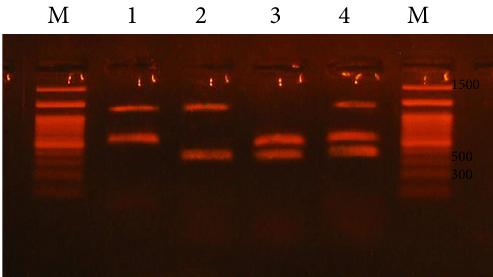
Fig. 5. Multiplex PCR for virulence genes in E. coli isolates. Lane (1): hlyA and cnf-1 , Lane (2): hlyA and papC , Lane (3): cnf-1 and papC , Lane (4): hlyA , cnf-1 and papC , Lane (M): 100 bp DNA ladder